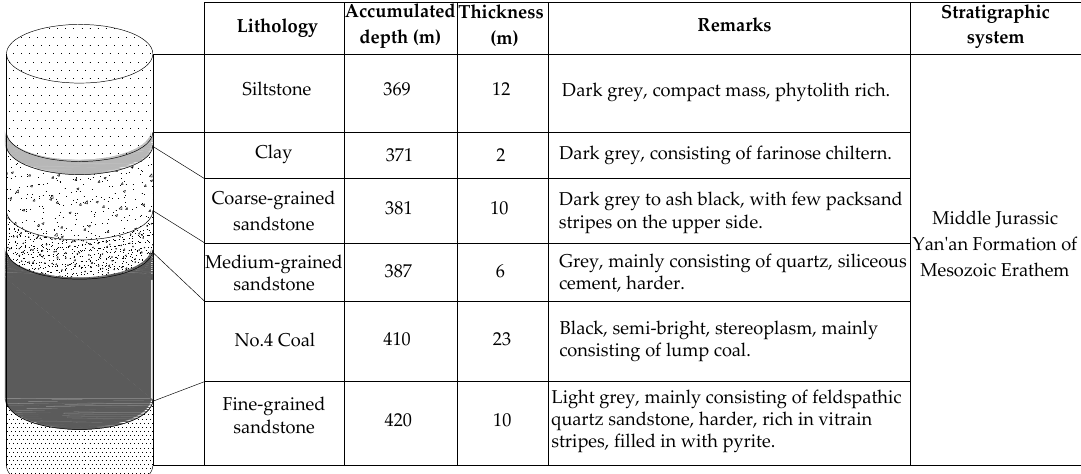
Figure 6. Location of the Hujiahe coal mine (Xianyang, Shaanxi, China).